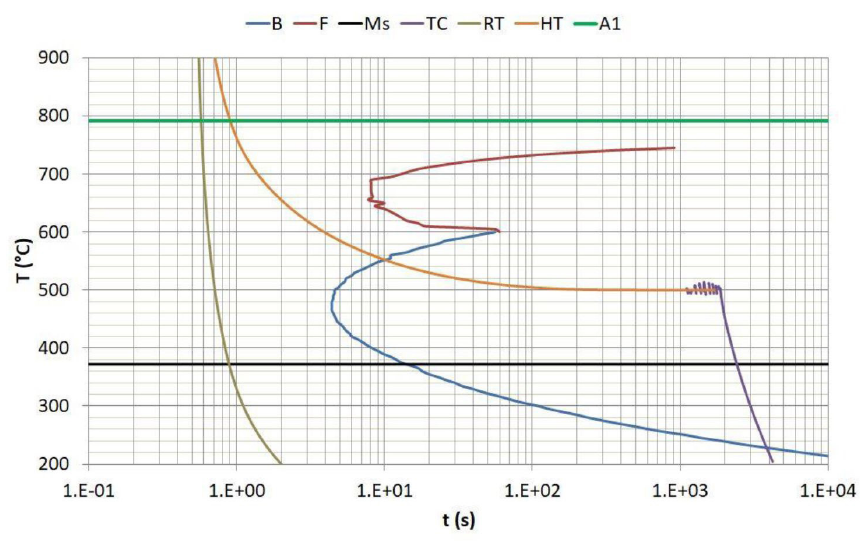
Figure 1. Response functions (temperature versus time) of the micro-constituents for the SAE 4130 steel.